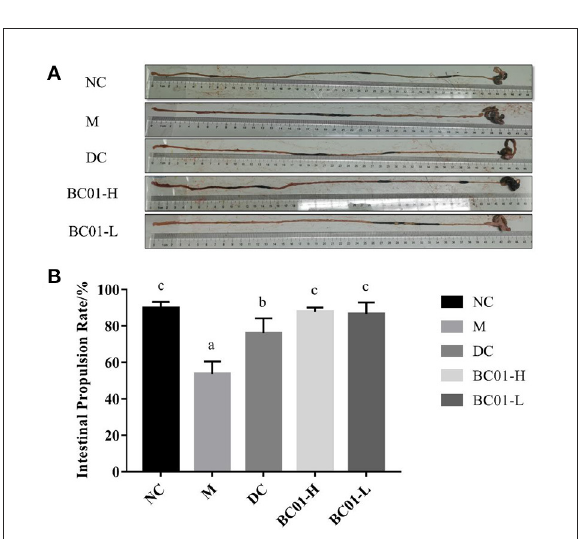
FIGURE3 Small intestinal propulsion rate in mice. (A) Small intestine anatomy. (B) Small bowel advancement rate. The different letters among the experimental groups indicated statistical differences ( p < 0.05). NC, normal group; M, constipation model group; DC, bisacodyl control group; BC01-H, B. coagulans BC01 high-dose group; BC01-L, B. coagulans BC01 low-dose group ( n =